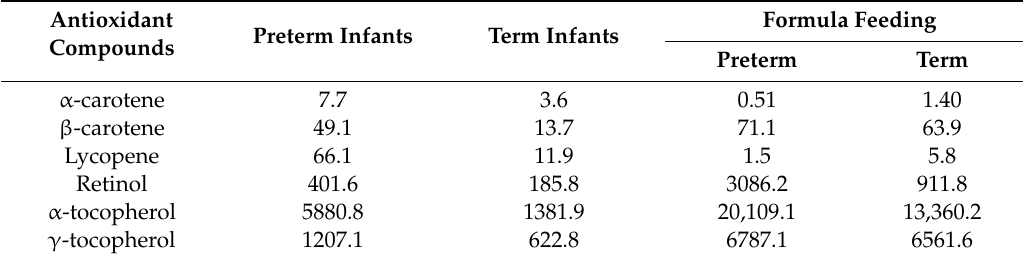
Table 1. Exogenous antioxidants in